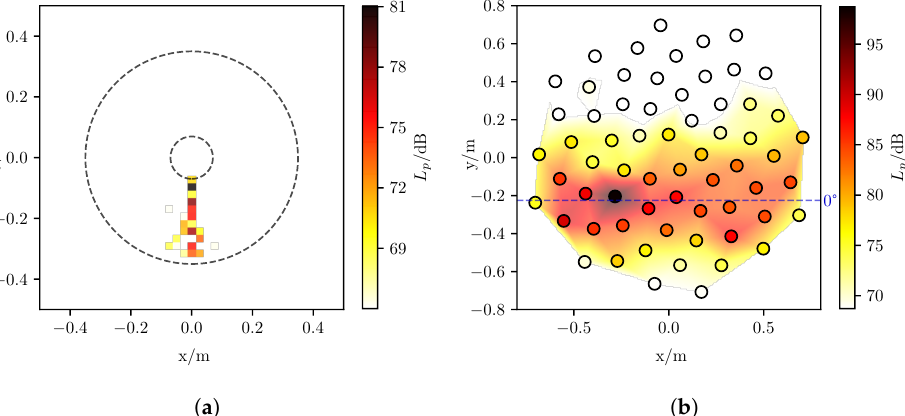
Figure 9. Test case 6 Simulated data with a rotating speaker array and no steering: ( a ) source distribution; ( b ) source directivity in the direction of the microphones at the 5 kHz octave band. The blue dotted line indicates the theoretical maximum at 0 ◦